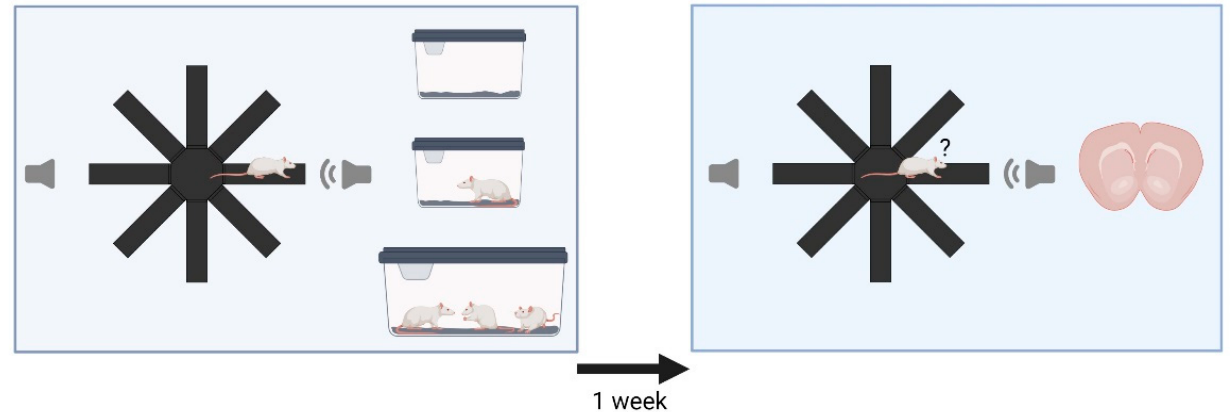
Figure 1. Graphical illustration of the experimental design. The animals underwent an initial playback test ( left box ), after which they were exposed either to an empty cage, a non-familiar social partner, or their respective group. Playback in the retest ( right box ) was identical to that of the initial test but was followed by the procedure of brain removal.